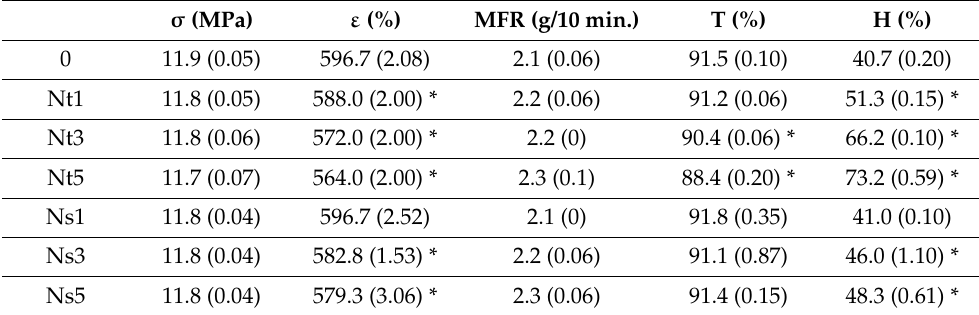
Table 3. Comparison of selected LDPE film parameters with and without biocides (mean ± standard deviation in brackets). Statistically significant differences ( p < 0.05) compared to the control (0) are marked with asterisks. Abbreviations: as in Figure